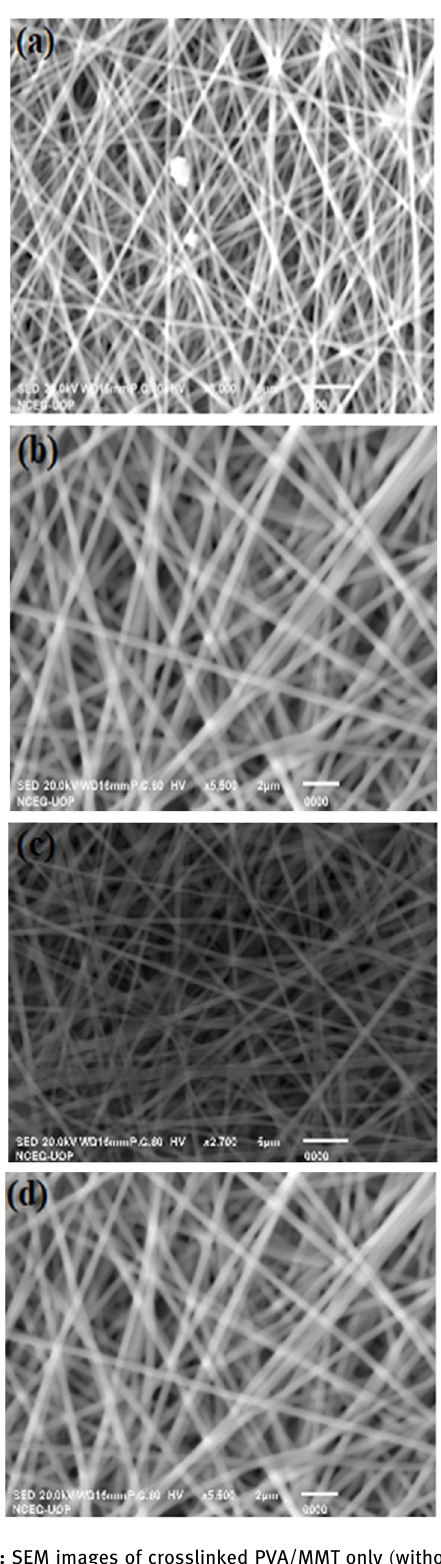
Figure 2: SEM images of crosslinked PVA/MMT only ( without extract ) ( a and b ) and with 0.8 g of the extract ( c and d ) .